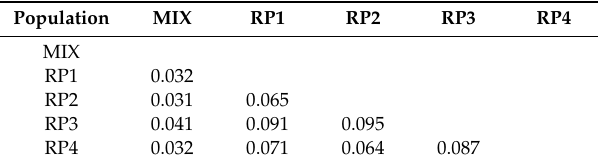
Table 4. The matrix of pairwise genetic di ff erentiation among populations